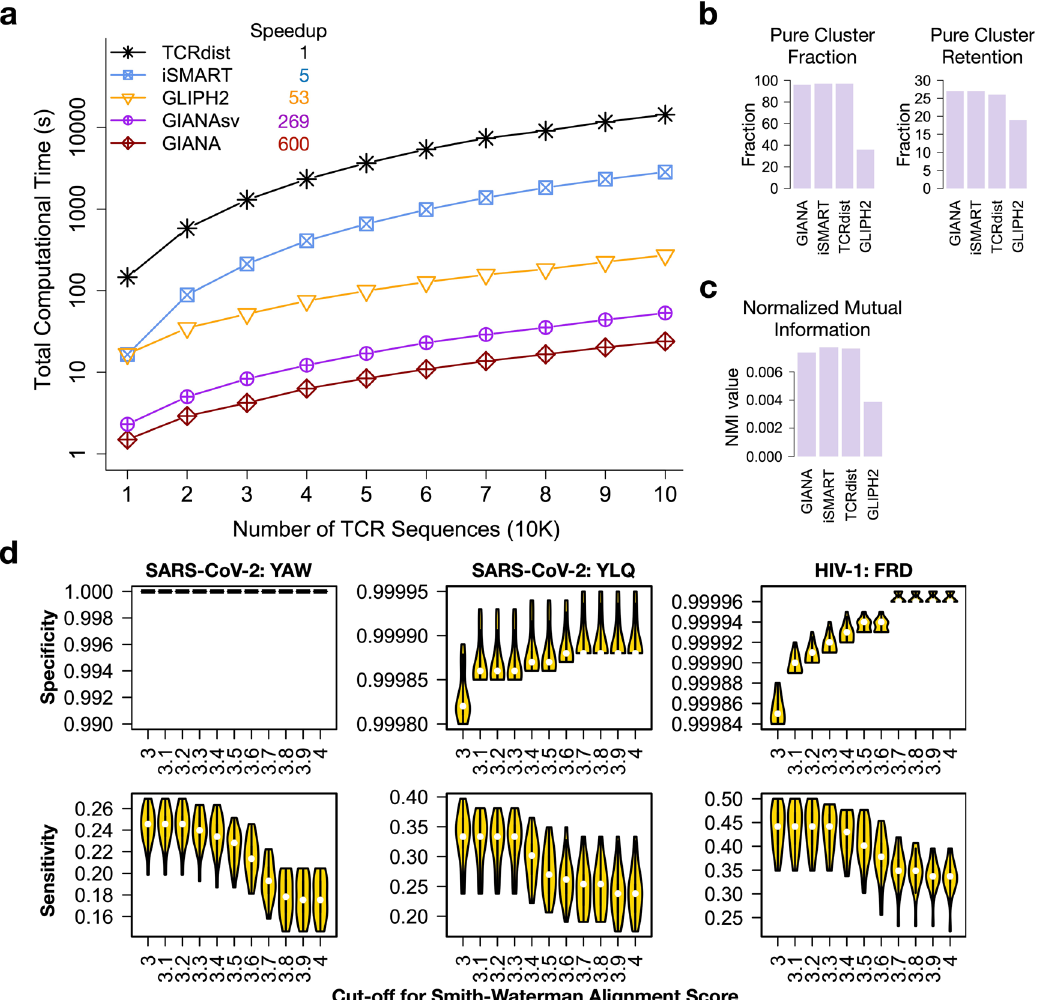
Fig. 2 Performance evaluation and comparison of different methods. a Comparison of time complexity for fi ve competing TCR clustering algorithms. Speedup was calculated based on the time cost for the 100 K TCR sample. b Comparison of purity cluster fraction and retention of four methods. y -axis shows the precision or sensitivity in percentage. c Normalized mutual information comparison of the four methods. d Sensitivity and Speci fi city of GIANA when applied to large and noisy TCR-seq samples. x -axis is the cutoff for Smith – Waterman alignment score, a key parameter in GIANA, with maximum 4.0. Higher cutoff results in higher speci fi city at the cost of reduced